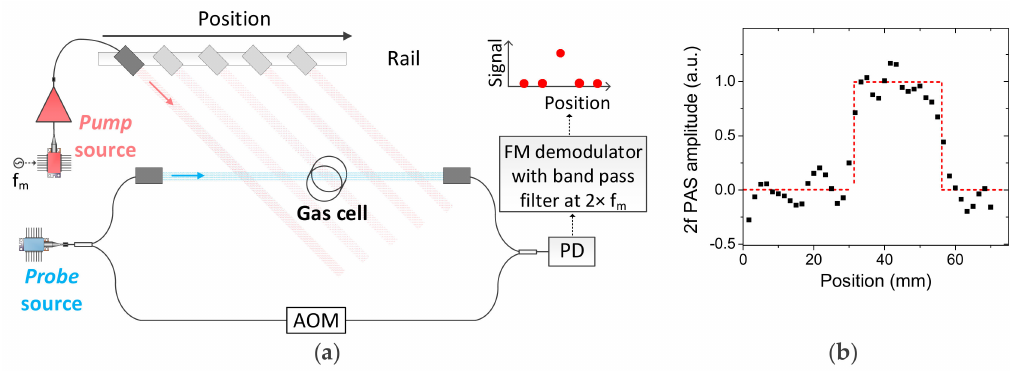
Figure 5. ( a ) PAS configuration for spatially resolved measurement. AOM—acousto optical